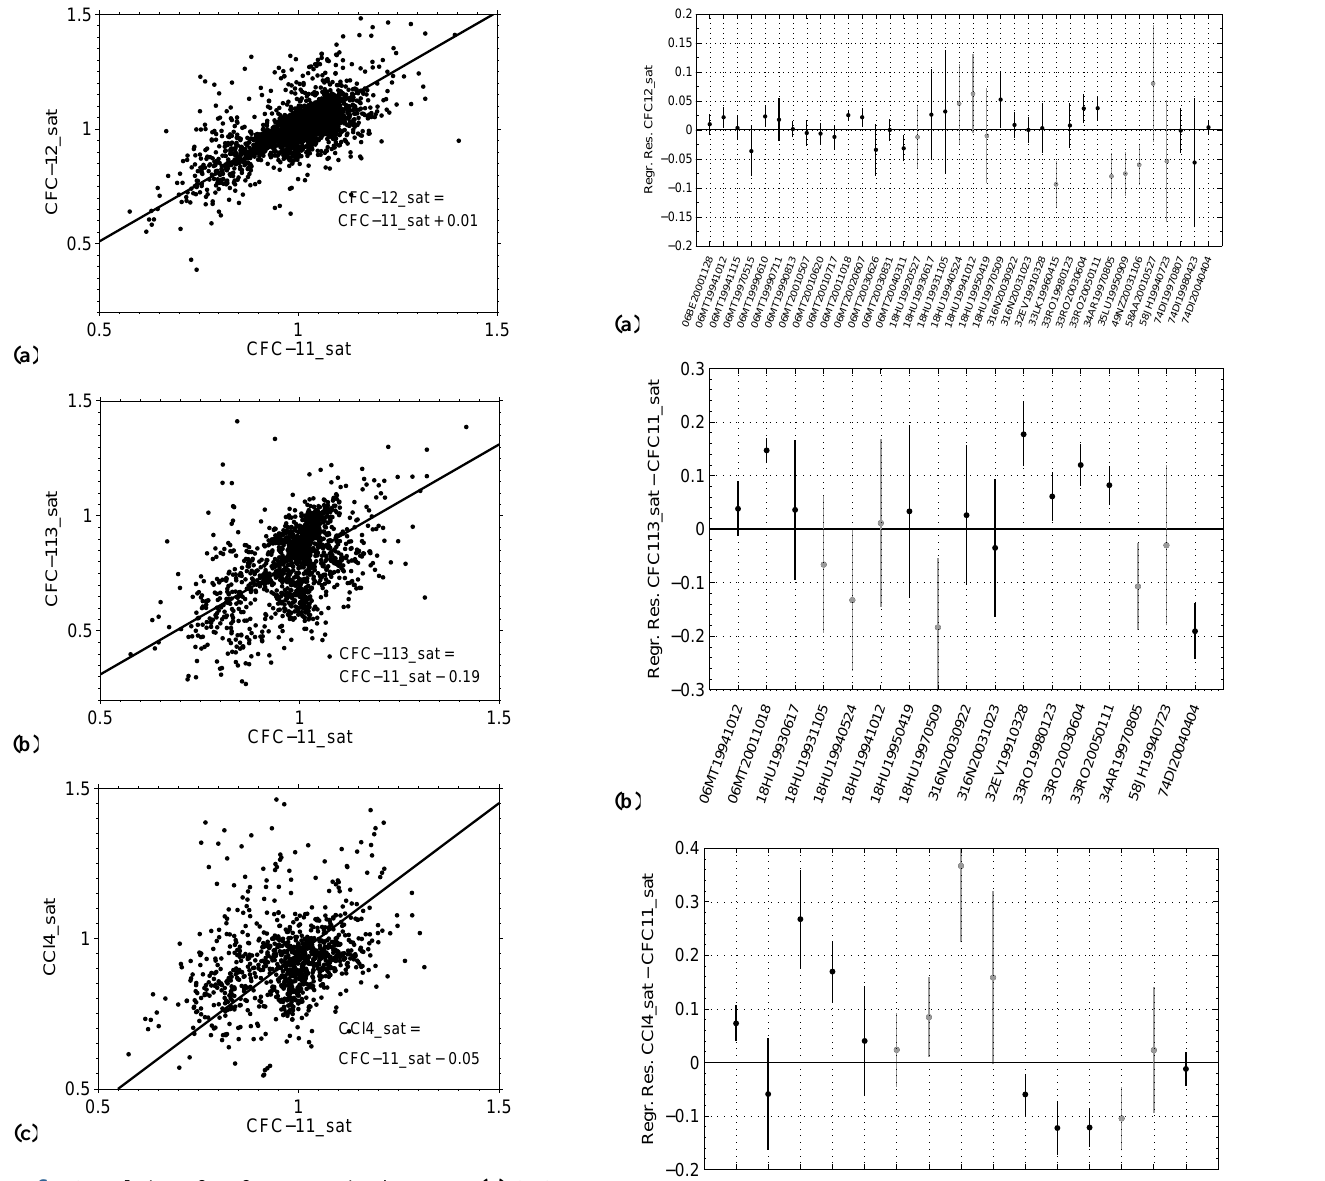
tive cruise. For CFC-113 and CCl 4 , the decomposition of these tracers in warm waters leads to larger deviations from the simple linear